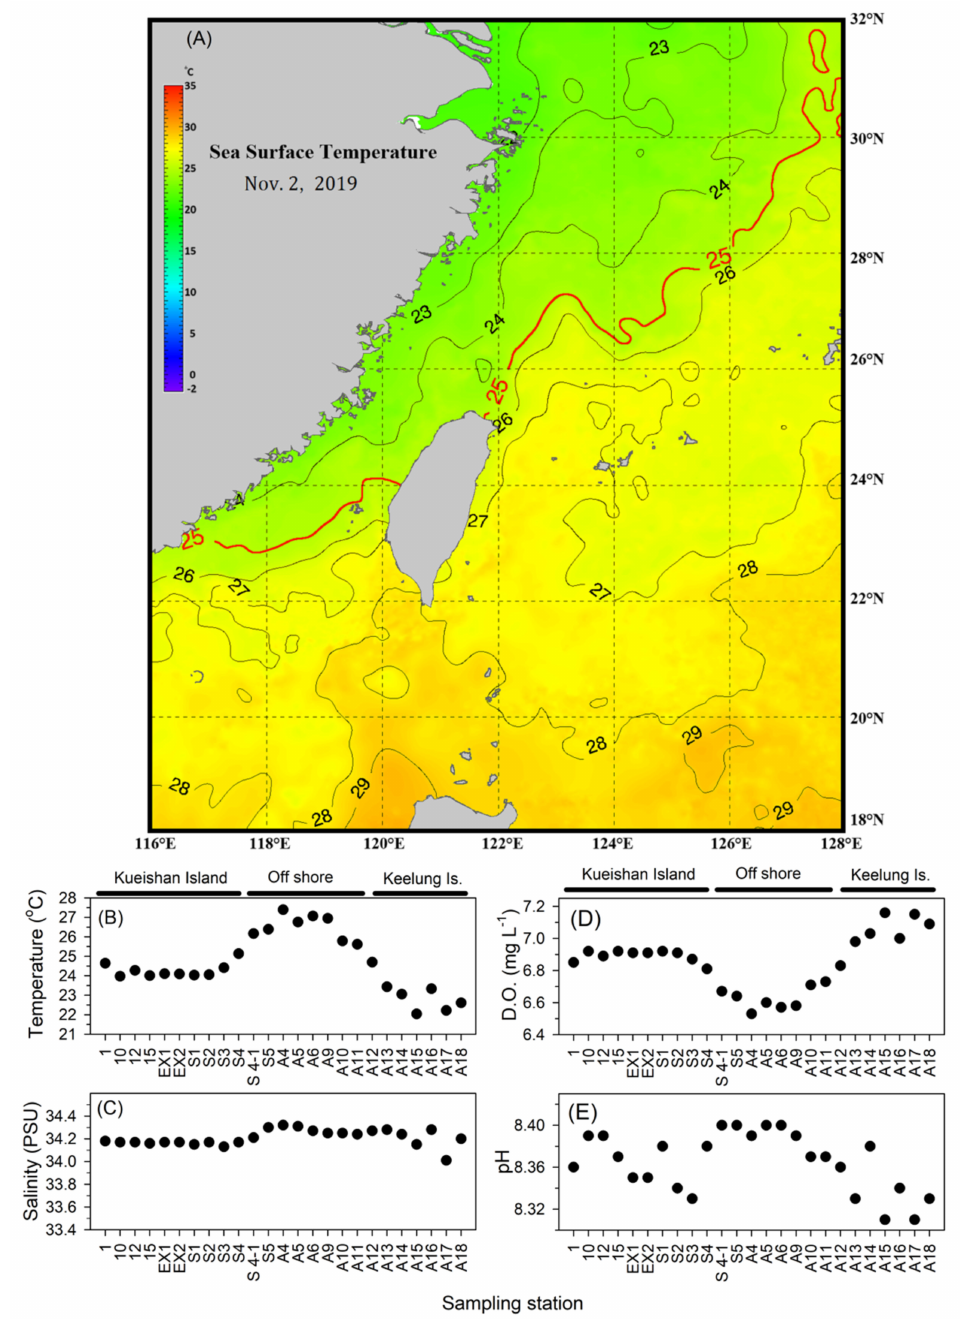
Figure 2. Surface water environmental parameter characteristics during the research. ( A ) Sea surface water temperature changes; ( B ) Temperature; ( C ) Salinity; ( D ) Dissolved oxygen; ( E )